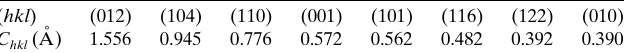
Table 7 Magnitudes of C hkl in LiNbO 3 .